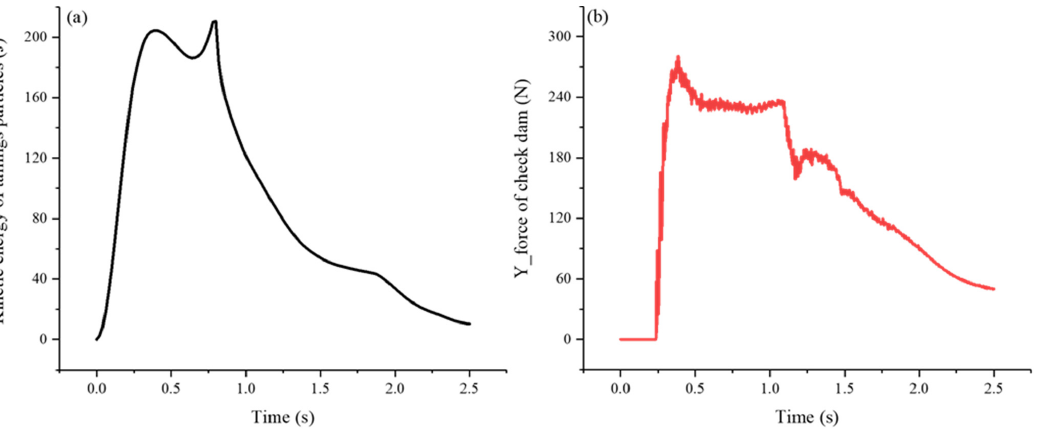
Figure 5. Evolution of ( a ) kinetic energy of tailings slurry and ( b ) impacting force in Y direction on the catch dam.